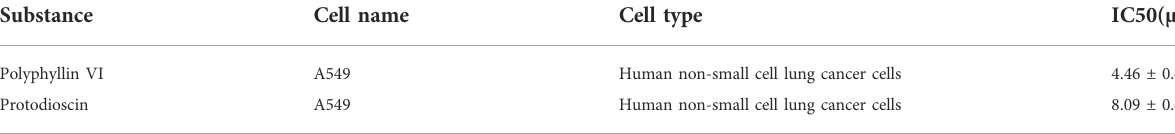
TABLE 1 Effects of Polyphyllin VI and Protodioscin treatment on IC50 ( μ M) of A549 cells. Substance